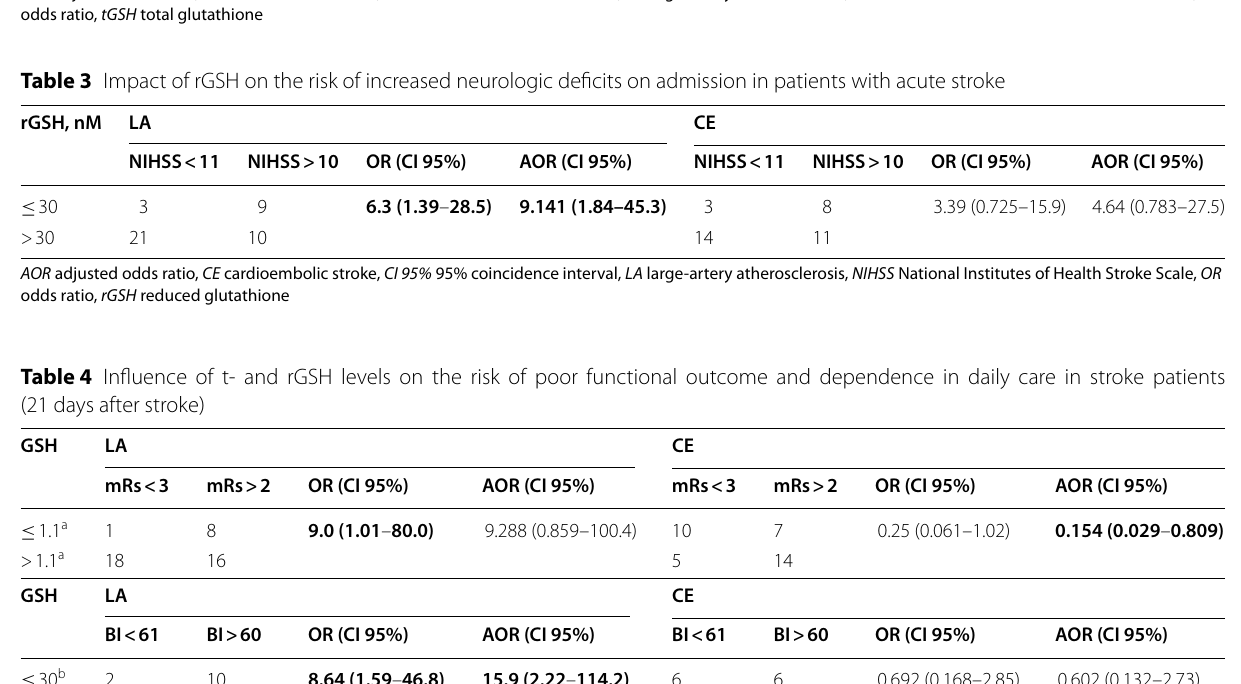
AOR adjusted odds ratio, CE cardioembolic stroke, CI 95% 95% coincidence interval, LA large-artery atherosclerosis, NIHSS National Institutes of Health Stroke Scale, OR odds ratio, tGSH total glutathione Table 3 Impact of rGSH on the risk of increased neurologic deficits on admission in patients with acute stroke